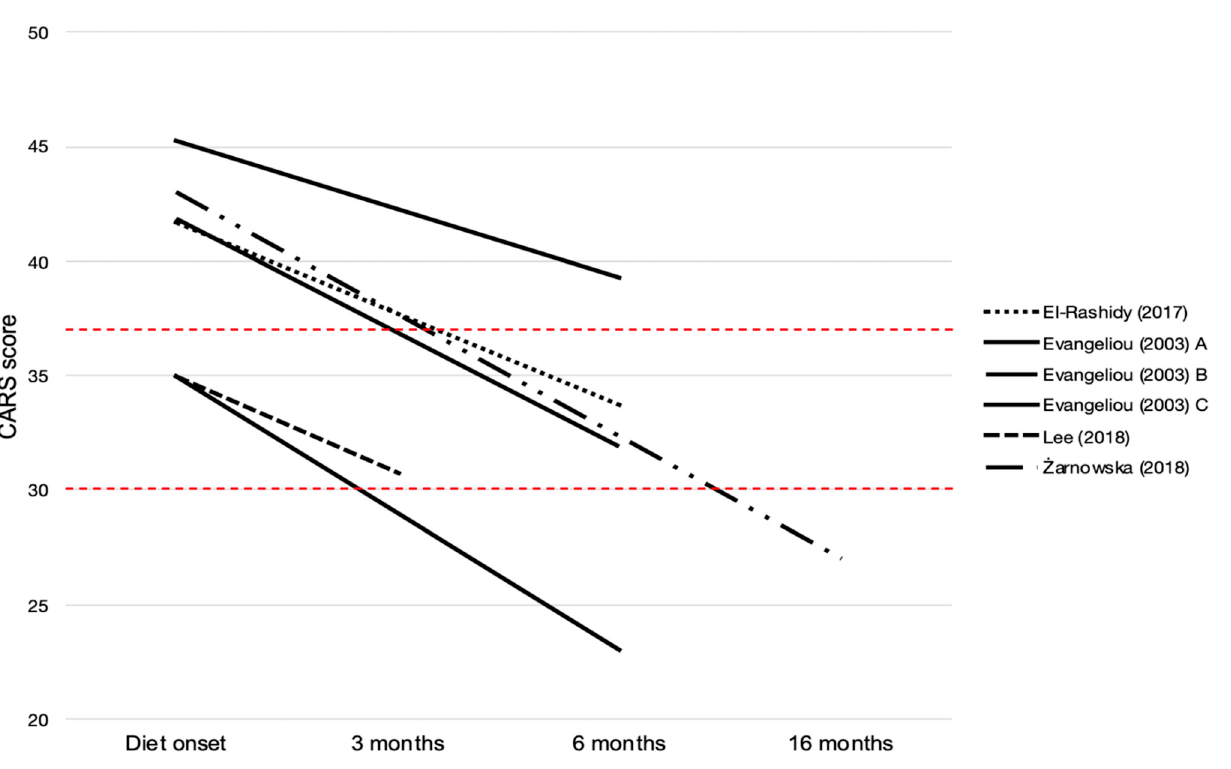
Figure 2. Changes in CARS scoring in reviewed papers. The total scores range from 15 to 60, and the cutoff score to determine autism is 30. A score of <30 is classified as non-autism. A score of 30–36 is classified as mild to moderate autism. A score of ≥ 37 is classified as severe autism [31] .